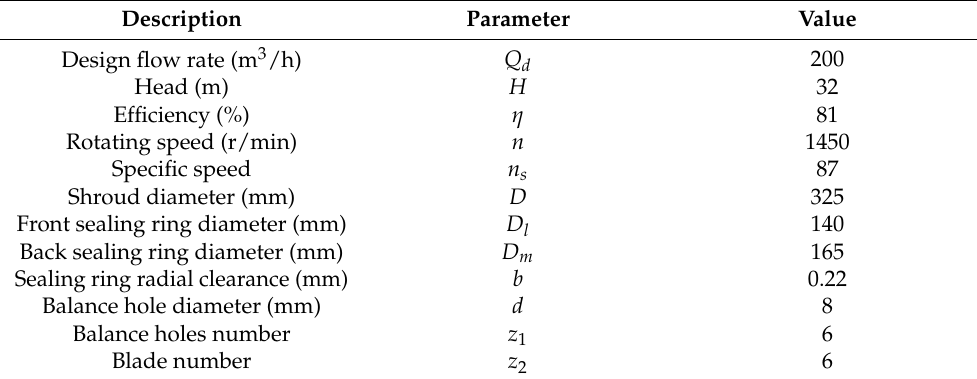
Table 1. Design parameters of single-stage single-suction centrifugal pump. Description